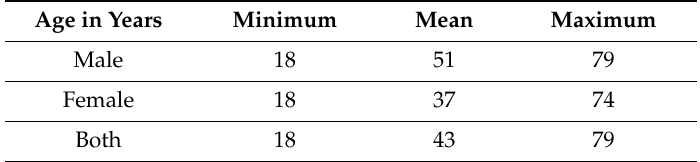
Table 1. Age distribution of patients who participated in the study ( n =